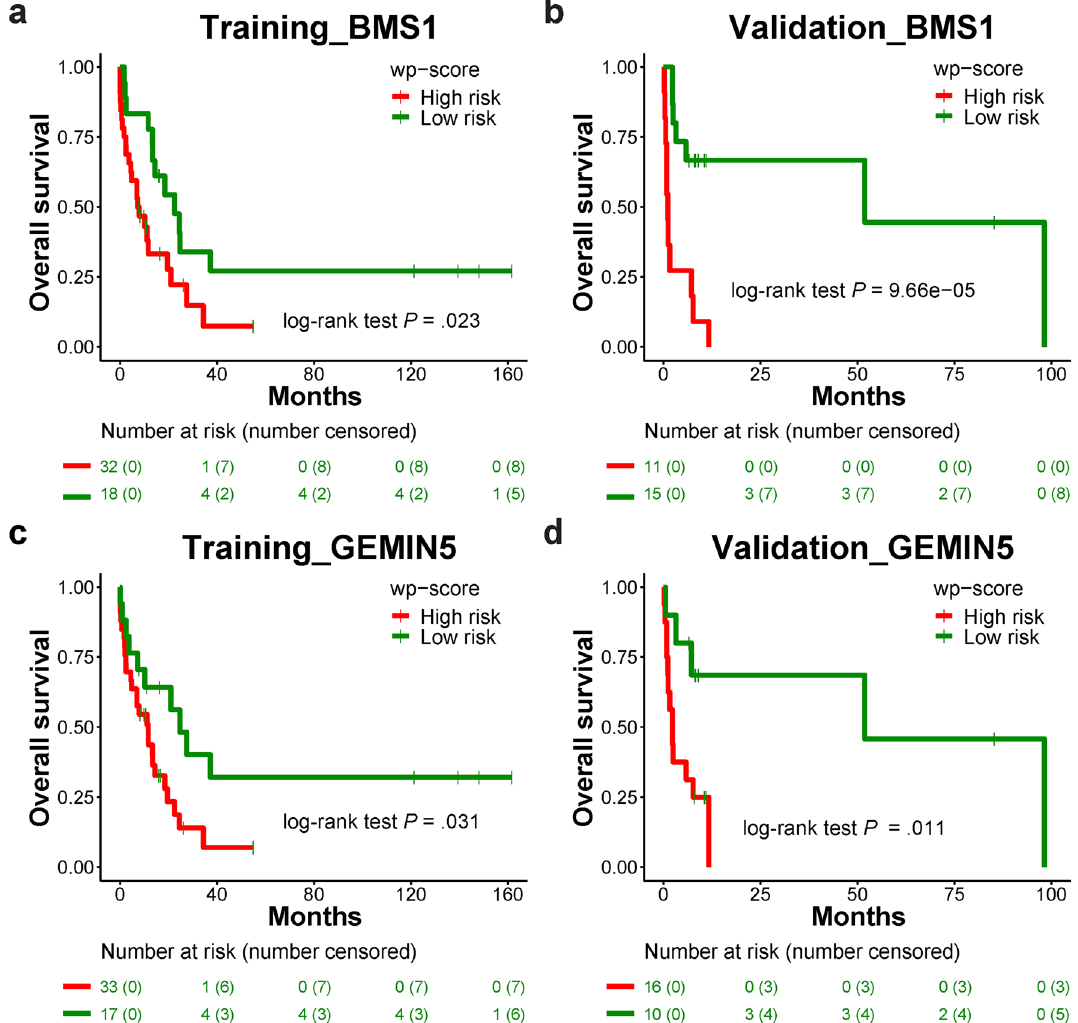
Figure 5. A 5hmC levels in a single gene for survival prediction. ( a ) Kaplan–Meier analysis of overall survival of AML patients in training set based on wp-scores of BMS1 (n = 50). ( b ) Kaplan–Meier analysis of overall survival of AML patients in validation set based on wp-scores of BMS1 (n = 26). ( c ) Kaplan–Meier analysis of overall survival of AML patients in training set based on wp-scores of GEMIN5 (n = 50). ( d ) Kaplan–Meier analysis of overall survival of AML patients in validation set based on wp-scores of GEMIN5 (n =